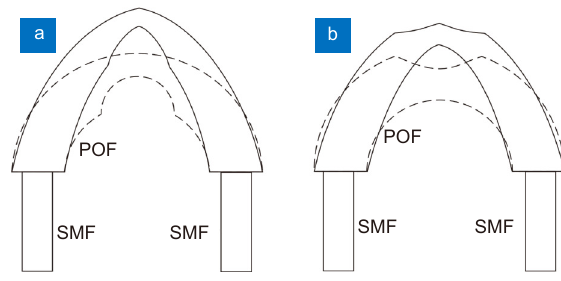
Fig. 11 | Schematic diagram of stress change. ( a ) SDB. ( b ) ODB. The dotted line is evenly stressed and the solid line is not evenly stressed. Fig. 12 | Intensity response of RI sensor.